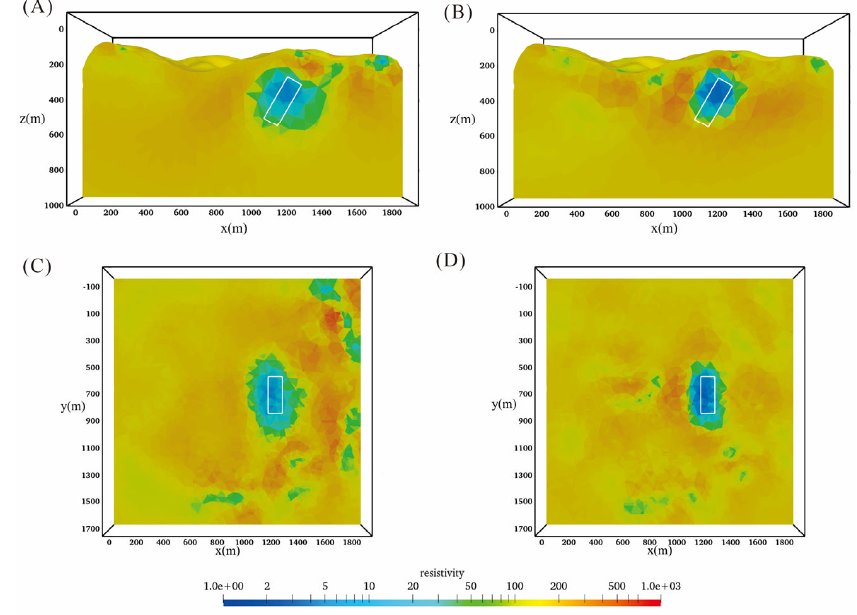
Figure 7. 3D inversions of an inclined ore body model. ( A , C ) are vertical and horizontal clips at y=750 m and z=350 m of single ‐ component inversion result for the inclined ore model respectively, while ( B , D ) are the corresponding clip of multi ‐ component inversion results for the inclined ore model.